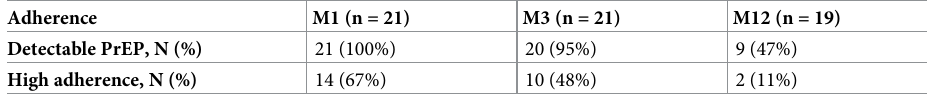
Table 3. PrEP adherence for qualitative sample (n =